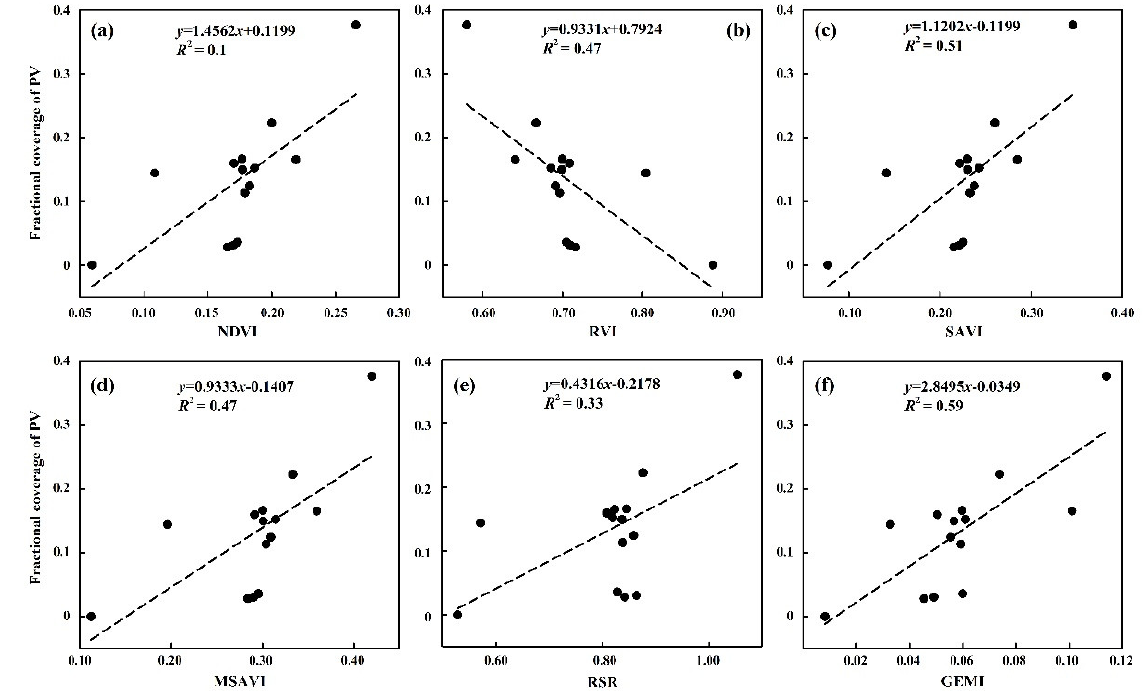
Figure 5. Linear regression between different PVIs and the f PV . The PVIs are ( a ) NDVI, ( b ) RVI, ( c ) SAVI, ( d ) MSAVI, ( e ) RSR and ( f ) GEMI, respectively.